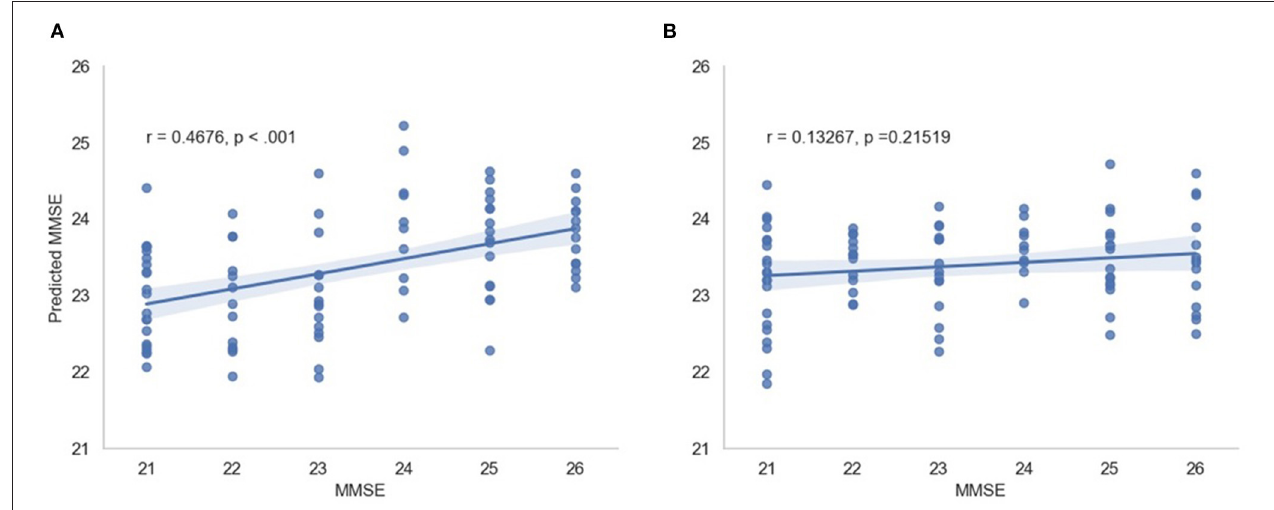
FIGURE 7 | Predicted MMSE vs. observed MMSE for the cross-validation trial with the best performance for (A) the proposed model and (B) the random